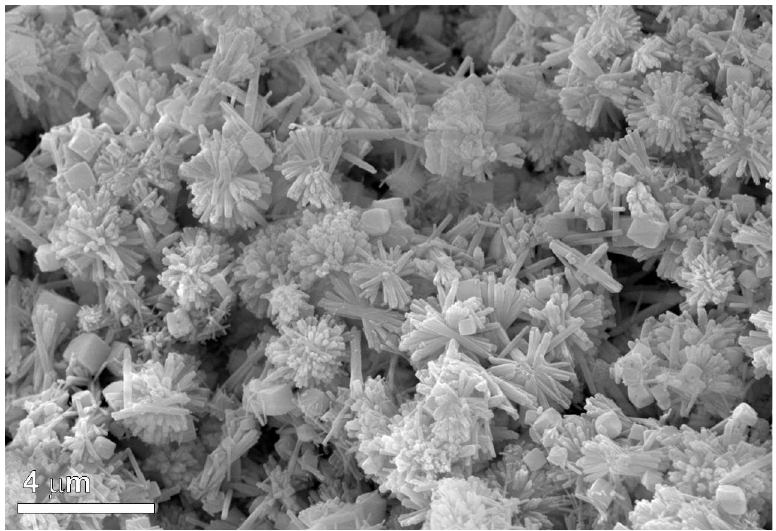
Fig 5. Calculus internal portion and mineral phases. SEM secondary electrons image of loose material from the internalportion of stone S3: coexistingcrystals of apatite (tabular/prismatic crystals of hydroxylapatite forming radiatingclusters) and whitlockite (rhombohedral crystals).